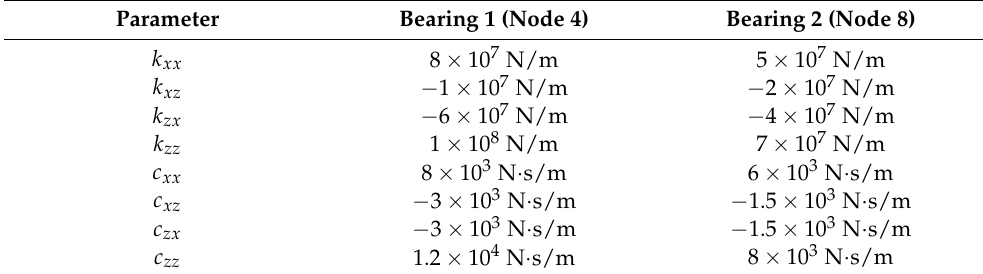
Table 3. Stiffness and damping bearing parameters [40].